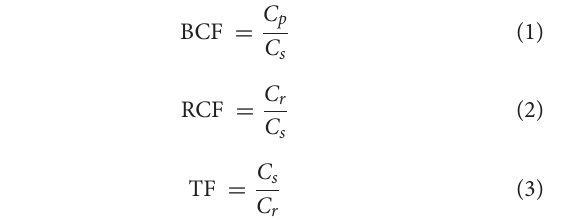
TABLE 1 | Pot experiment soil treatment.